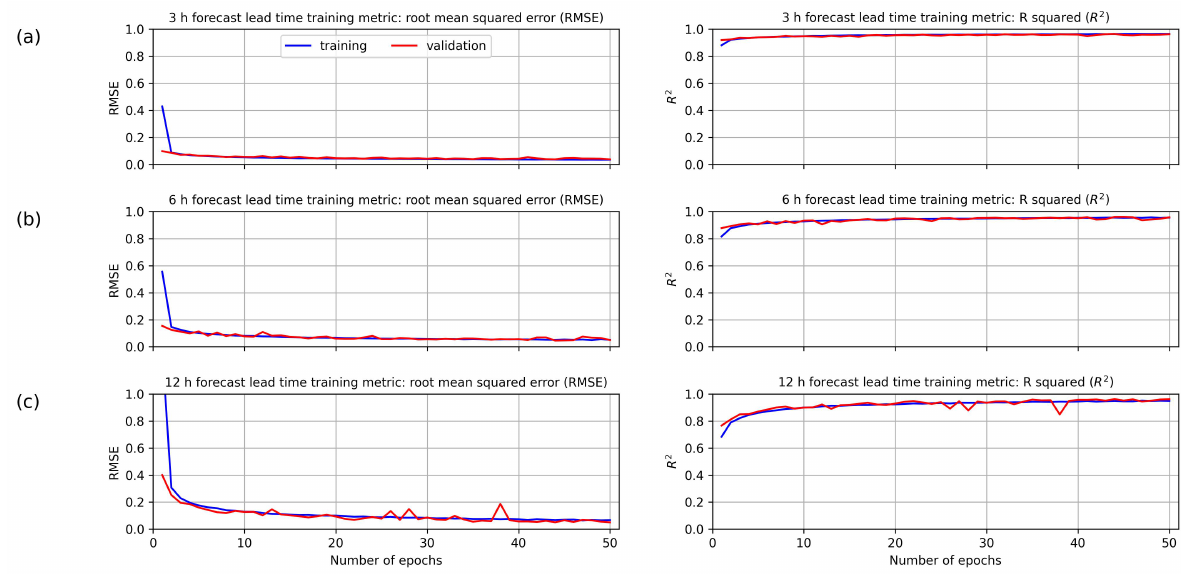
Figure 7. The neural network model training metrics for three forecast lead times (i.e., 3 h, 6 h, and 12 h) from ( a – c ) for save point SP13205. Two metrics, root mean square error (RMSE) and R squared ( R 2 ), were used.